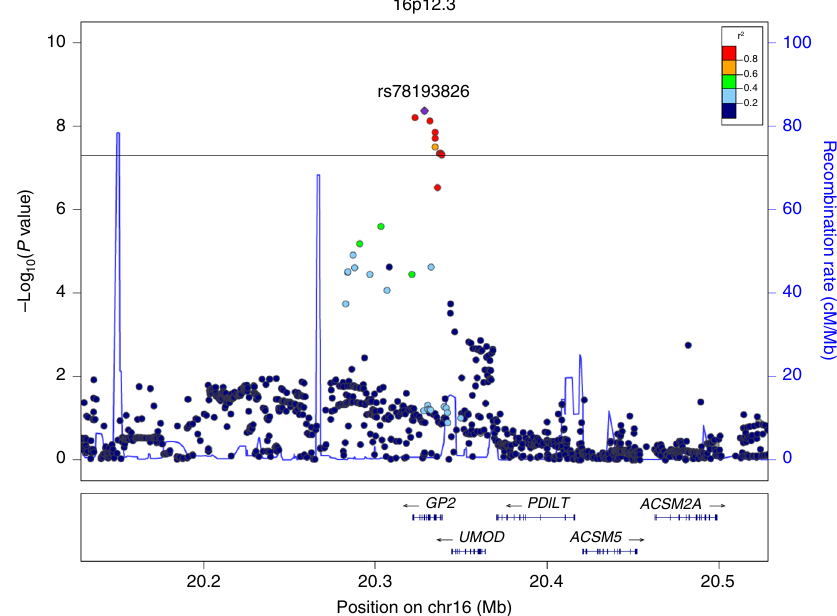
Fig. 2 Regional association plot for the 16p12.3 locus identi fi ed in the meta-analysis. The vertical axis indicates the – log 10 ( P value) for the assessment of the association of each SNP with pancreatic cancer risk. The colors indicate the LD ( r 2 ) between each lead SNP and neighboring SNPs based on the JPT population in the 1000 Genomes Project Phase 3. LD linkage disequilibrium, SNP single-nucleotide polymorphism, JPT Japanese.